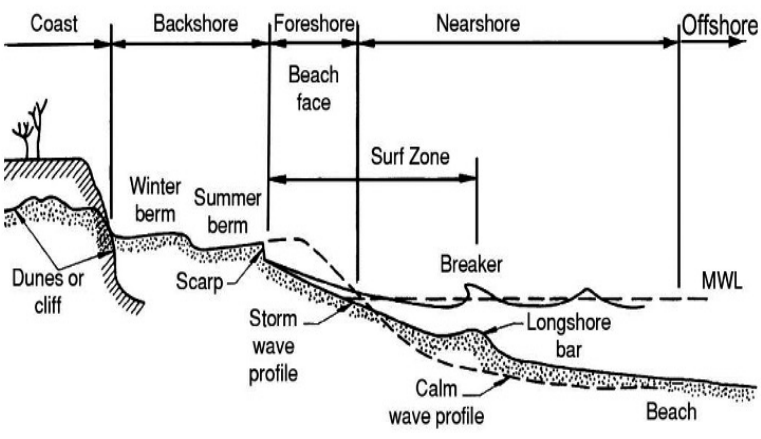
Figure 1. Schematic typical beach profile, terminology and zonation [10].